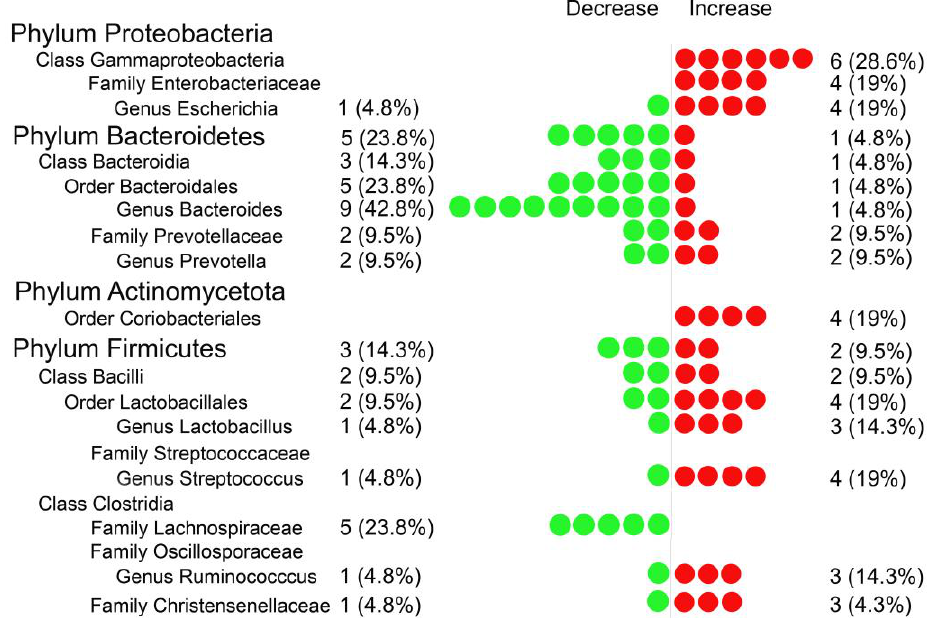
Figure 2. The results of a systematic review. The red circles describe the percentage of articles with increased bacterial relative abundance in CAD patients. Oppositely, green circles describe the percentage of articles with decreased bacterial relative abundance in CAD patients. One circle represents one study analyzed.